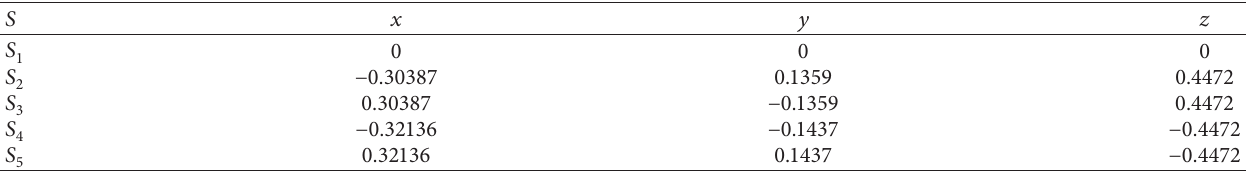
Figure 1: Chaotic behavior of fractional-order ] � 0 . 96 with initial conditions [ 2 , 1 , 1 ] and [ 5 , 1 , 1 ] . Table 1: Equilibrium point of the system.